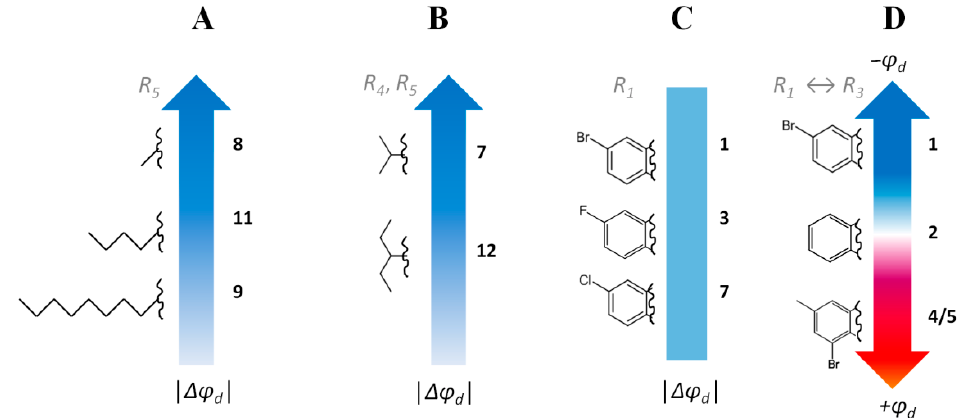
Figure 1. The relationships between the structures of allylmorpholines and their poten- tial-modifying abilities: the dependence of dipole modifying efficiency of allylmorpholines on ( A ) the length of hydrophobic chain in R 5 position; ( B ) lengths of hydrocarbon radicals in R 4 and R 5 positions; ( C ) the type of halogen in the R 1 position; ( D ) the existence of halogen in R 1 and R 3 posi- tions.